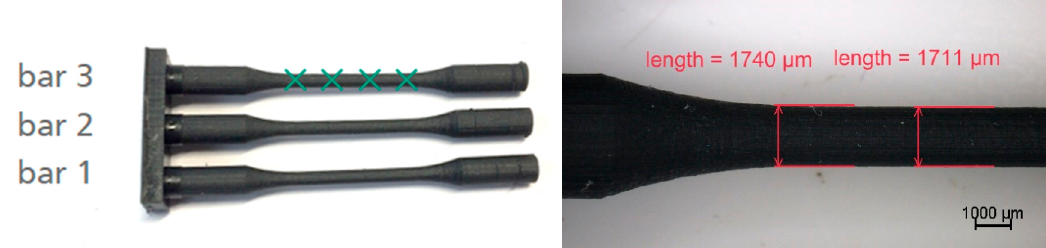
Figure 5. Round tension bars with exemplary markings of measuring points.